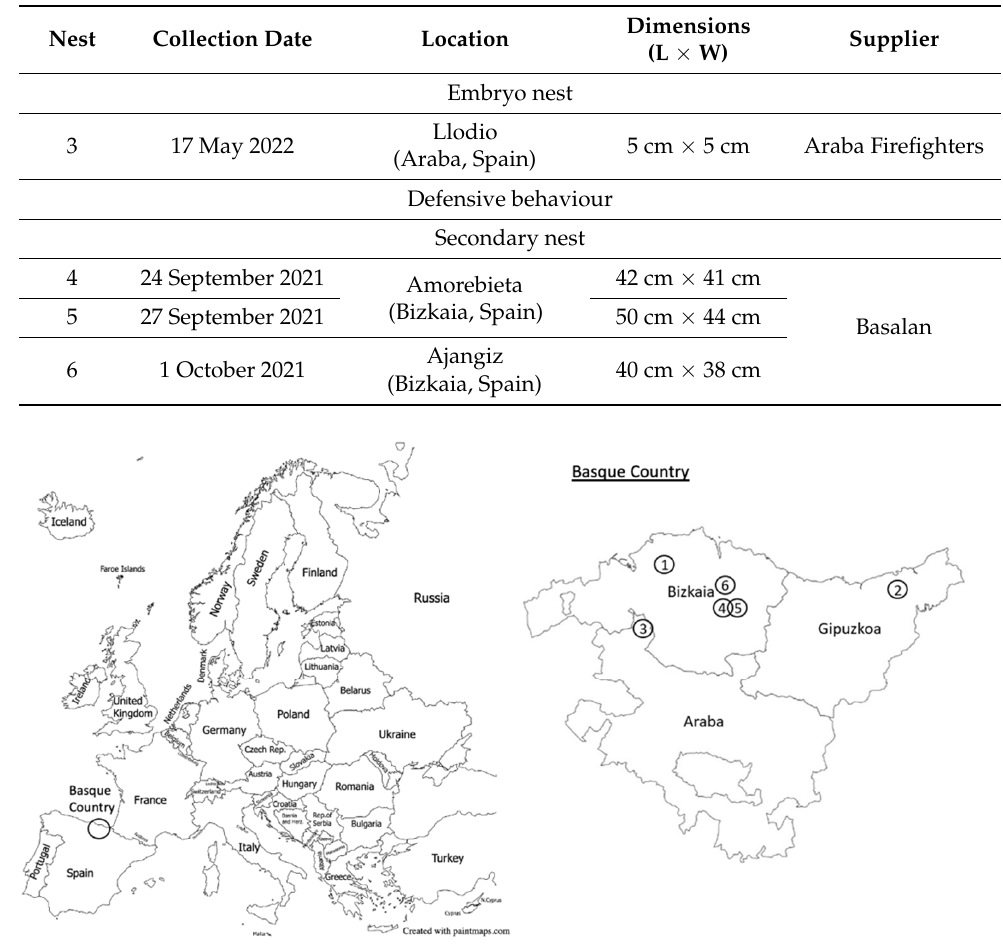
Figure 2. Location of the Basque Country in Europe ( left ). Map of the Basque Country, with its three counties ( right ). The numbers indicate the locations of the Vespa velutina supplied nests. Image modified from paintmaps.com (accessed on 4 September